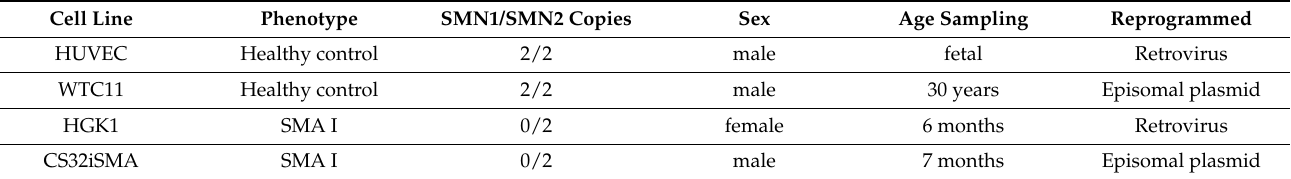
Table 1. Relevant information about hiPSC